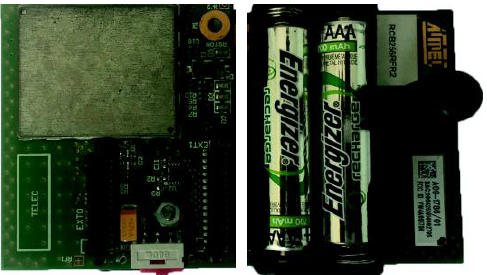
Figure 16. Atmel RCB256RFR2 node.